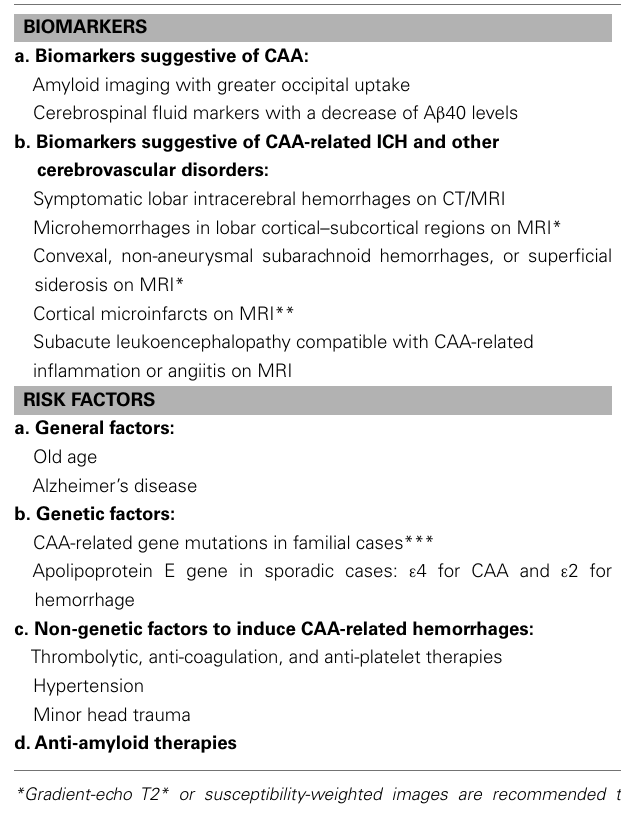
Table 1 | Biomarker findings and risk factors for cerebral amyloid and other cerebrovascular